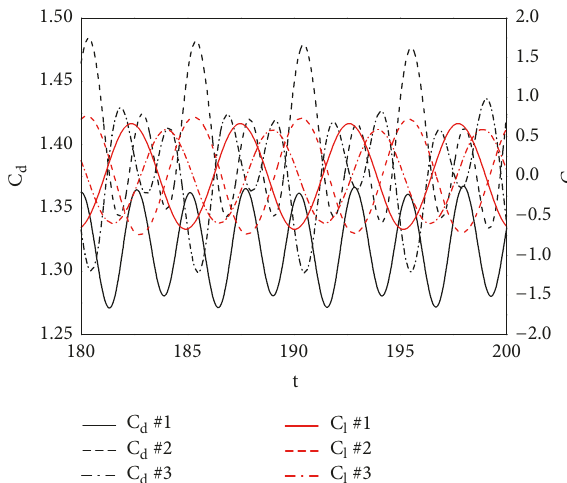
Figure 17: Temporal evolution curve of lift and drag coefficients for three cylinders at 𝑆/𝐷 = 1.5 .